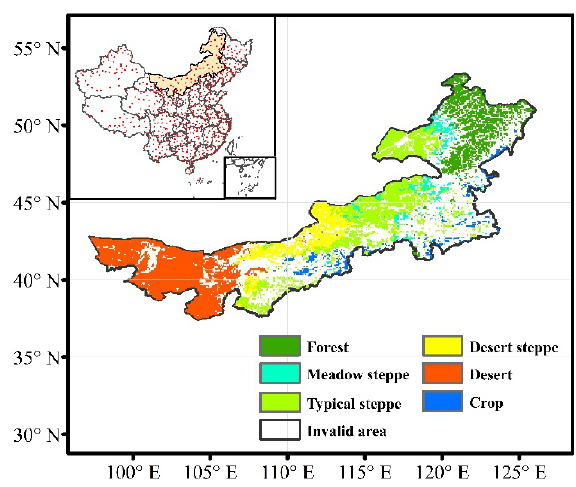
Figure 1. Vegetation types in Inner Mongolia. The insert indicates the location of the study area in China and the locations of 604 meteorological stations used in the study.